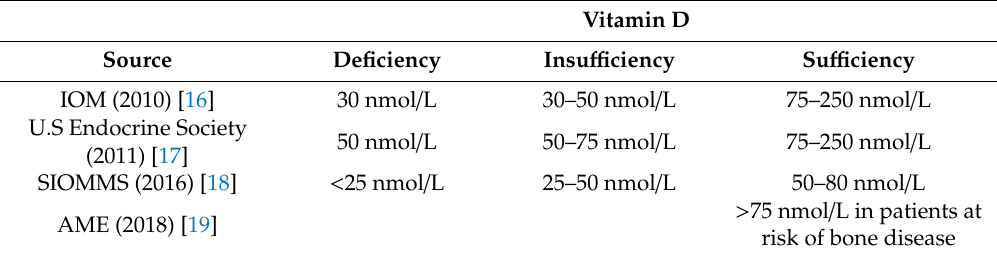
Table 2. Di ff erent vitamin D cut-o ff s used in clinical practice.